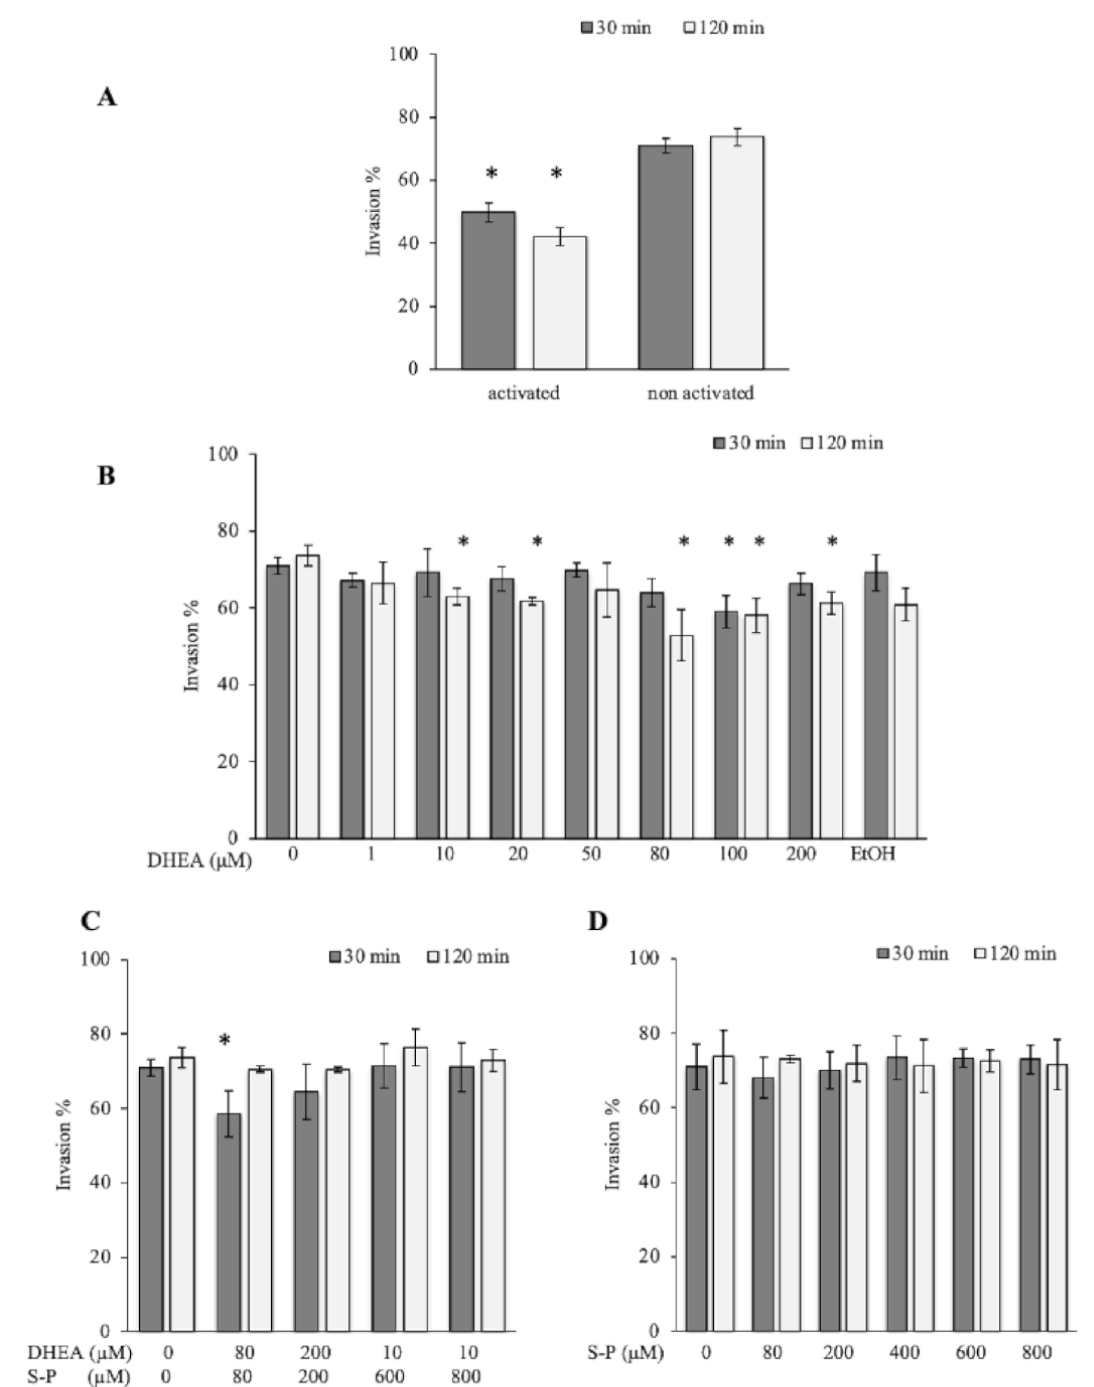
Figure 5. Effect of DHEA in the passive invasion process. ( A ) Activated vs. Unactivated lipopolysaccharides (LPS) macrophages ( B ) DHEA treatment ( C ) DHEA/S-P, and ( D ) S-P treatment; on the x -axis, the final concentration of each drug is plotted; while on the y -axis, the percentage of macrophages that contained at least one parasitophorous vacuole (PV) in the cellular cytoplasm is plotted. EtOH corresponds to DHEA solution vehicle (ethanol 2 µ M final concentration). (*) Statistical significance compared to the control according to exposure time. p < 0.05 compared to the control according to exposure time. p <